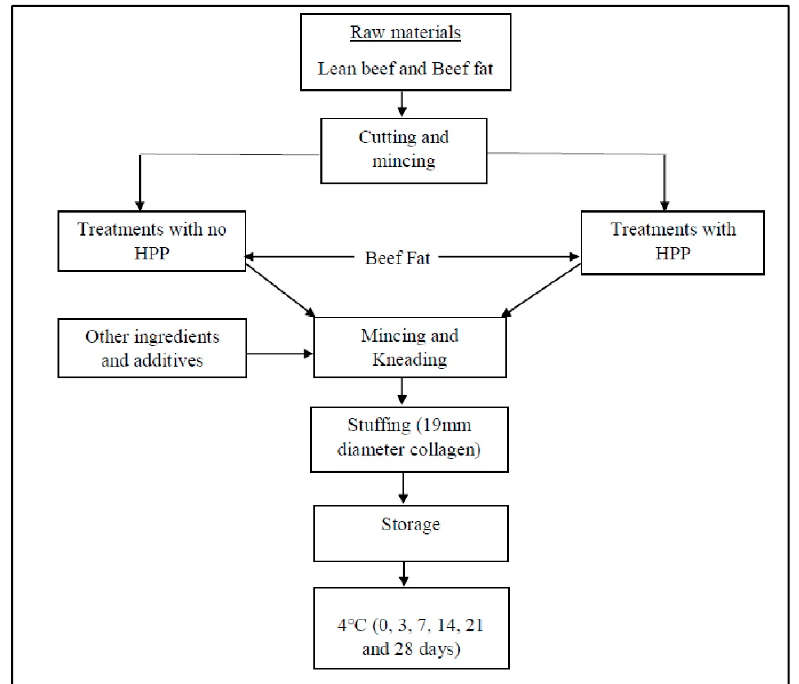
Figure 1. Flow diagram of the manufacture and storage of beef sausage under study (treatments with HPP and treatment with no